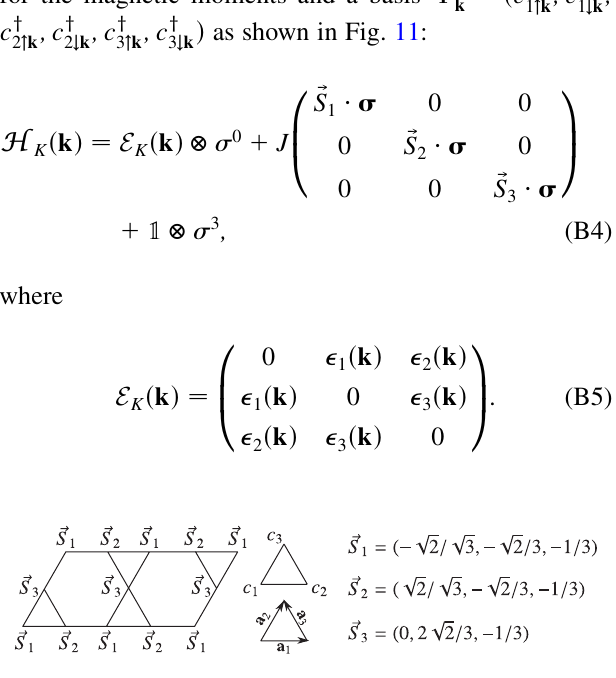
FIG. 11. An explicit chiral configuration of magnetic moments on the kagome´ lattice. For site i in sublattice a ¼ ~S 1 ; . . . ; 3 , S i ¼ a , as shown in the figure. The vectors lattice